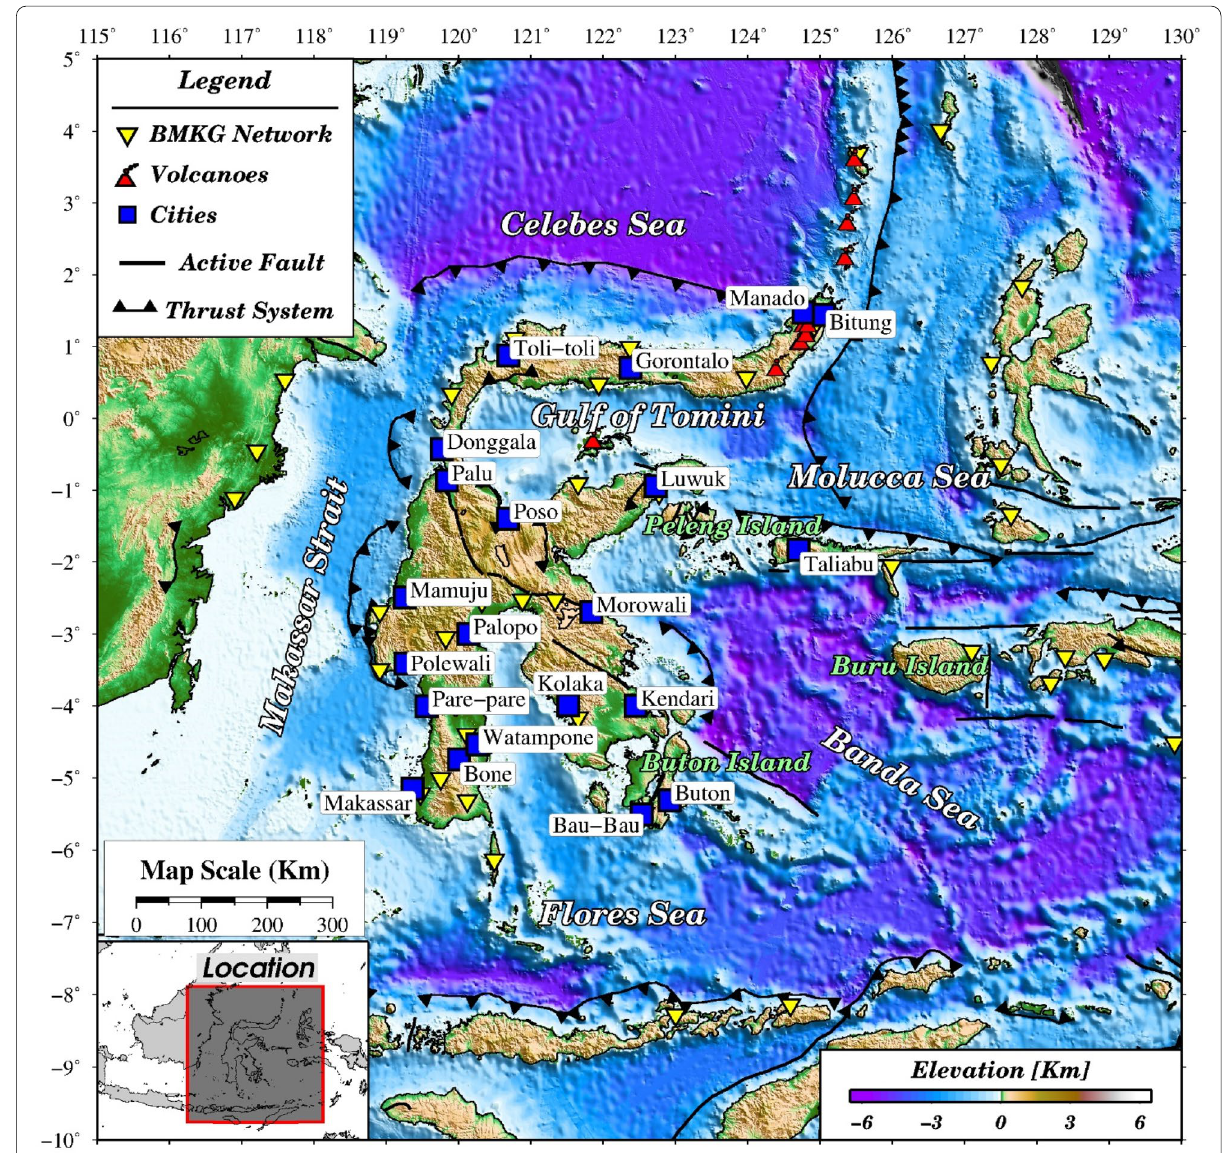
Fig. 1 Topography of the Sulawesi island including general tectonics and major